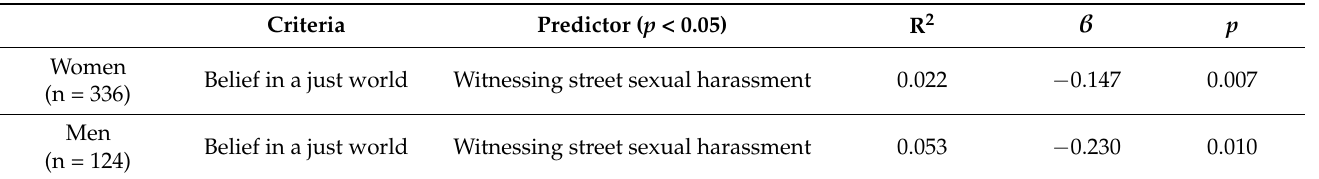
Table 7. Predictors of the characteristics of people who help. Criteria Predictor ( p < 0.05)